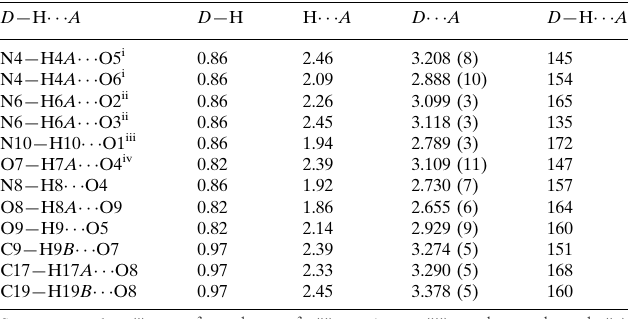
Hydrogen-bond geometry (A˚ , (cid:2)